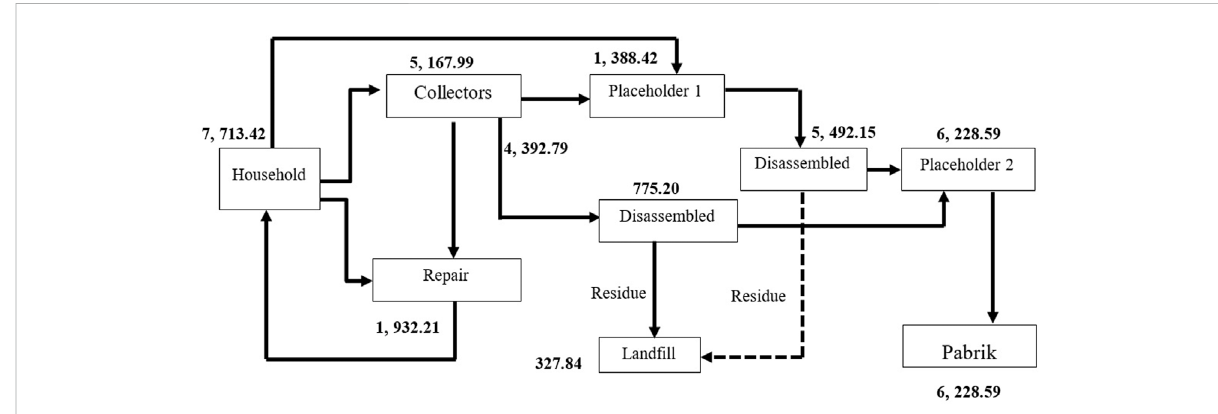
FIGURE 3 Mass Flow Analysis of electronic waste in DKI Jakarta existing